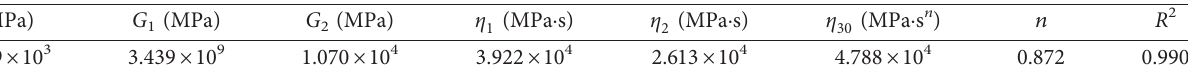
Table 1: NVPFM parameters of red sandstone under 15MPa confining